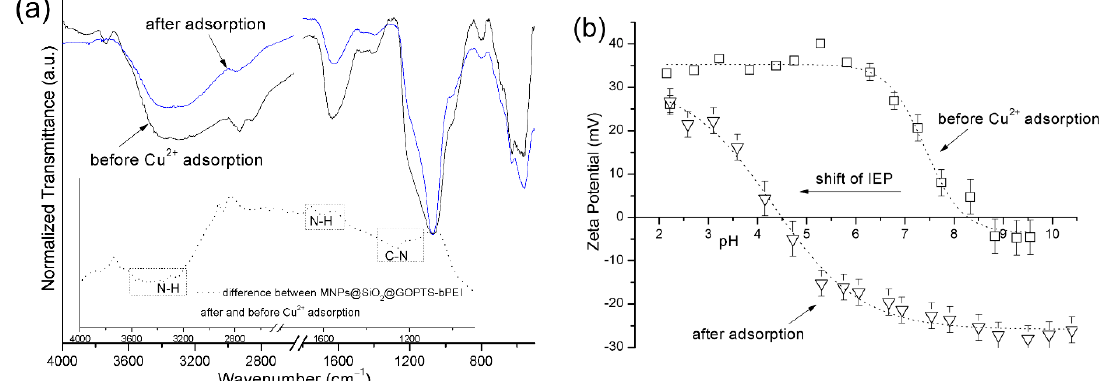
Figure 7. Attenuated Total Reflection ( ATR) FTIR spectra before and after Cu adsorption with corresponding difference between them ( a ), and Zeta Potential behavior as a pH function for MNPs@SiO 2 @GOPTS-bPEI before and after Cu adsorption ( b